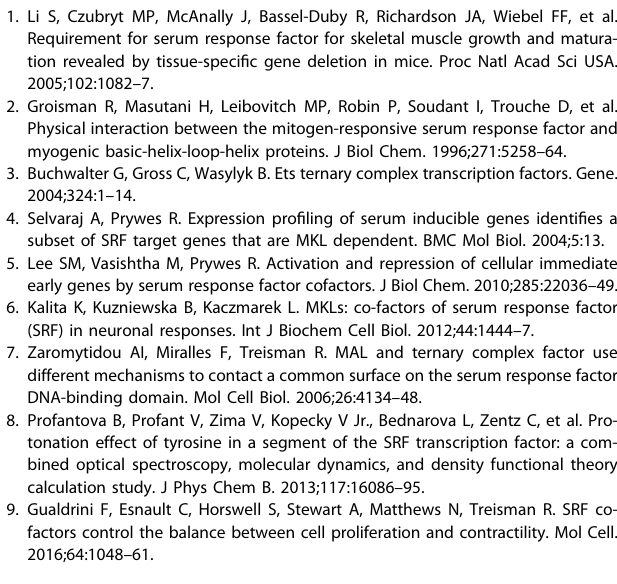
Fig. 9 Model of NLK/SRF/ELK Pathway. Work model of NLK regulating the balance between SRF/ELK and SRF/MKL through phosphorylating